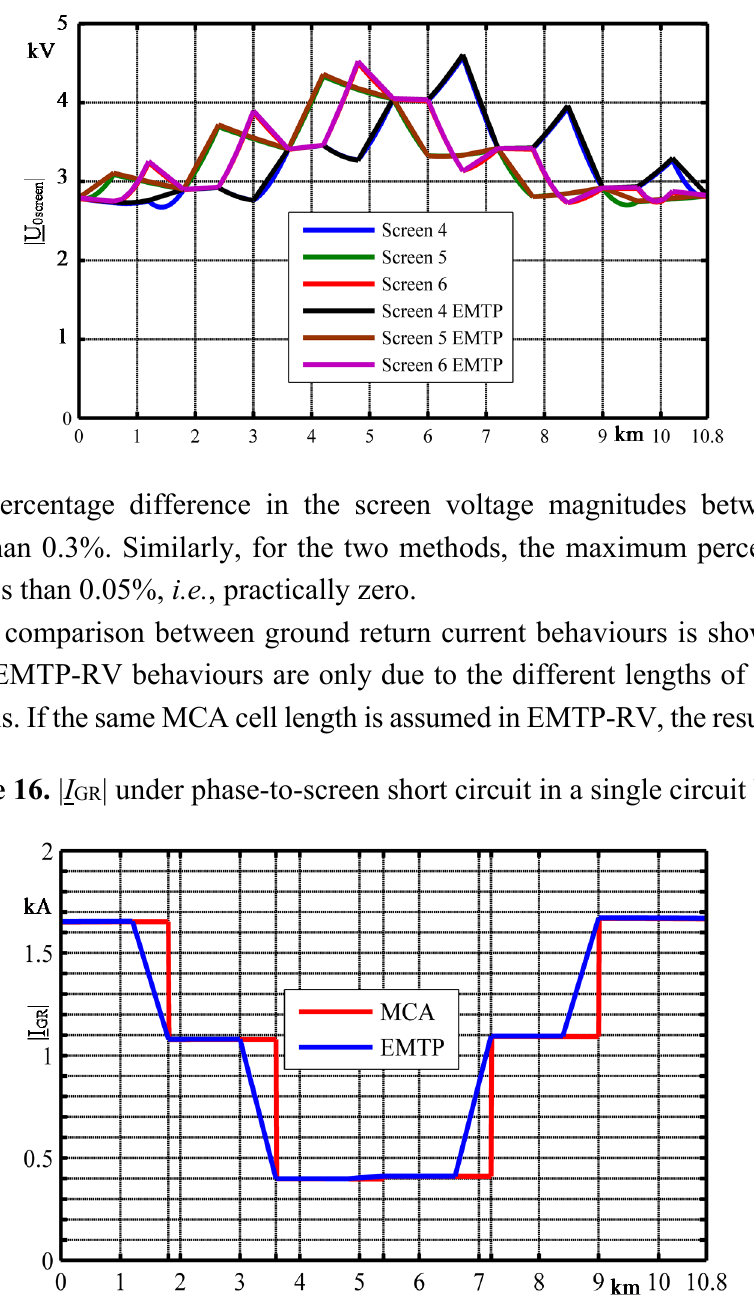
Figure 15. Screen voltage magnitudes comparison between MCA and ElectroMagnetic Transient Program-Restructured Version (EMTP-RV) under phase-to-screen short circuit in a single circuit UGC.